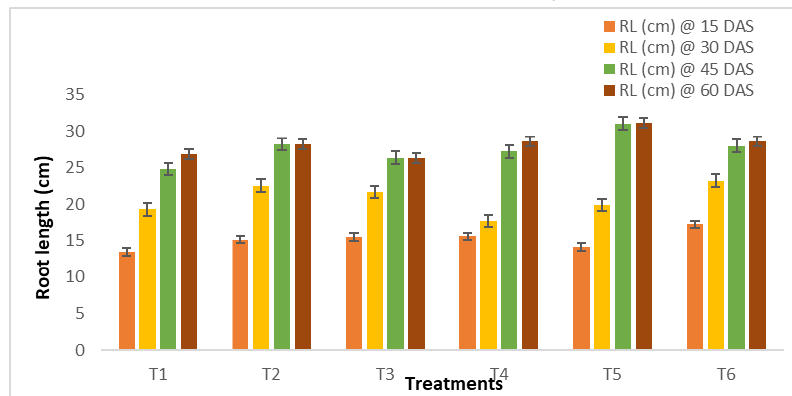
Figure 5. Effects of NPK consortia biofertilizer and chemical fertilizers on mean of root length at different growth stages; RL = Root Length, DAS = Days after